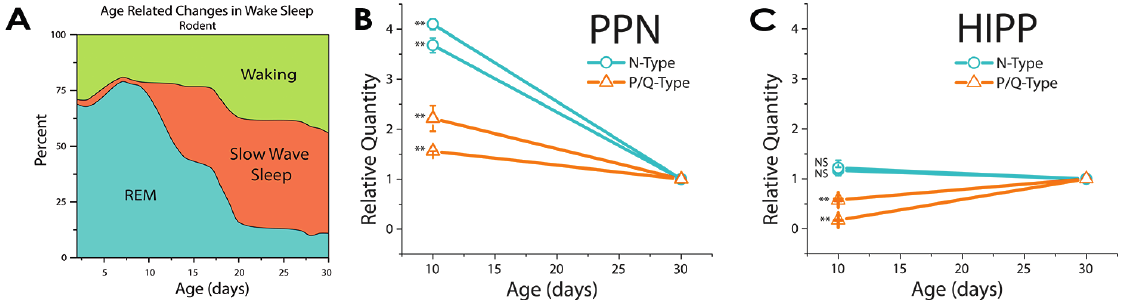
Figure 3. The developmental decrease in REM sleep and calcium channel